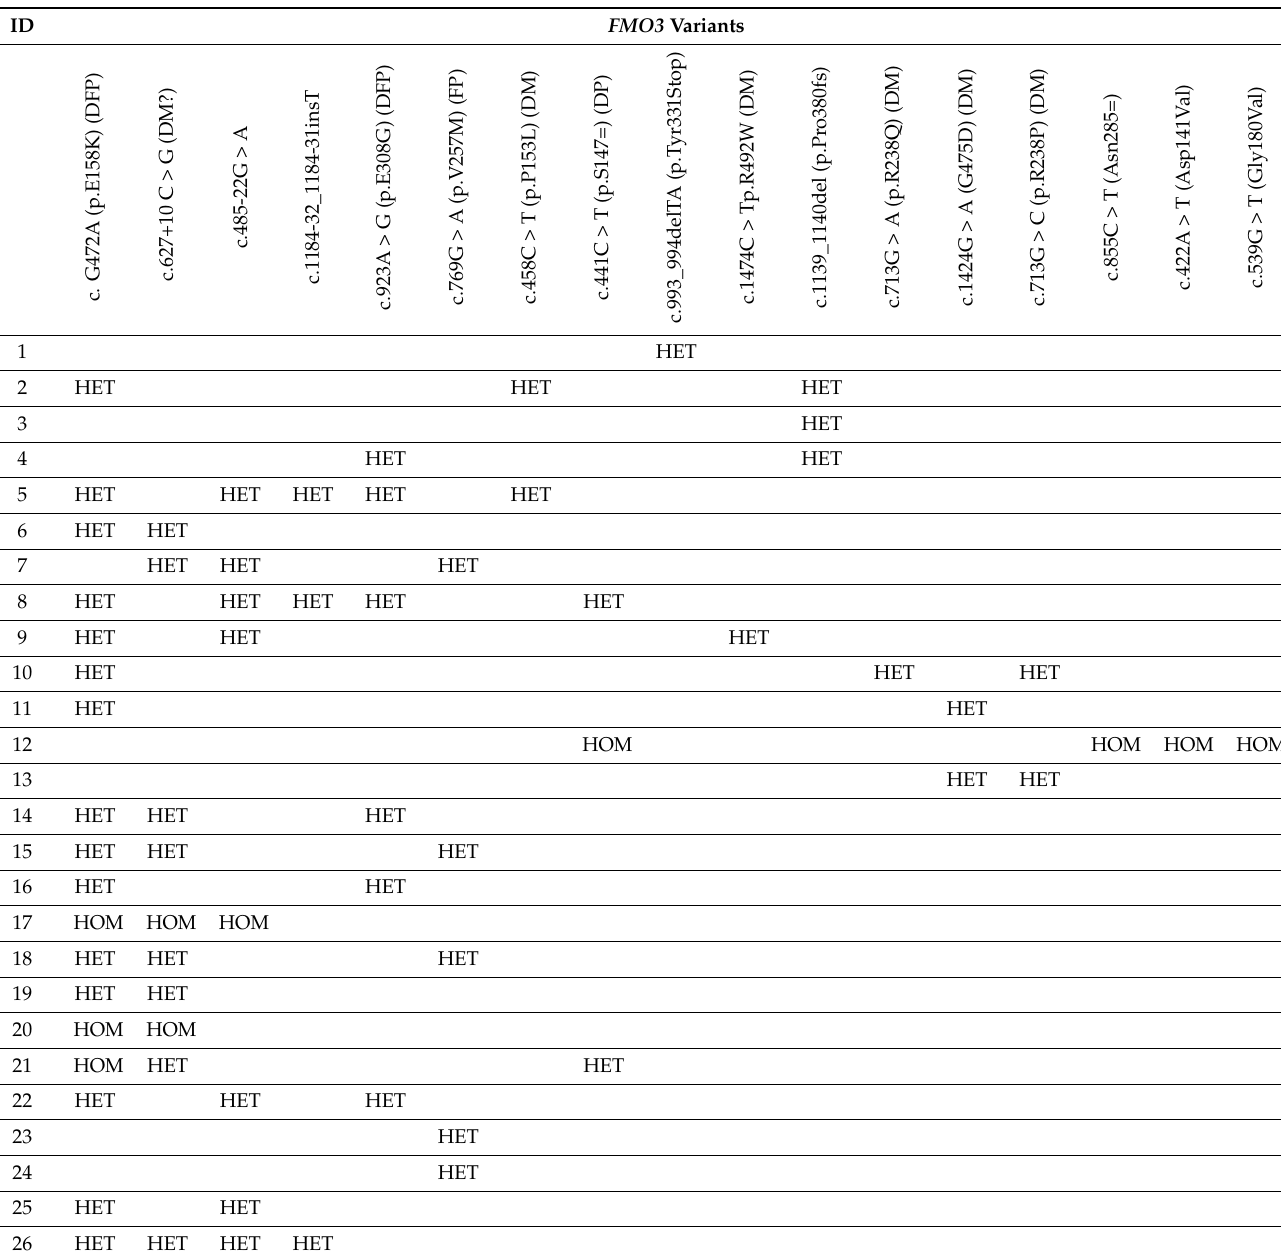
Table 1. FMO3 detected variants genotyping and distribution through the cohort of patients. Seventeen variants were identified during FMO3 genotyping of all twenty-six considered patients. DM = disease mutation (HGMD). DM? = disease mutation without certain evidence (HGMD). DFP = disease-associated polymorphism with additional supporting func- tional evidence (HGMD). DP = disease-associated polymorphism (HGMD). FP = in vitro/laboratory or in vivo functional polymorphism (HGMD). Variants without HGMD acronym are not yet fully evaluated. HET = heterozygous variant. HOM = homozygous